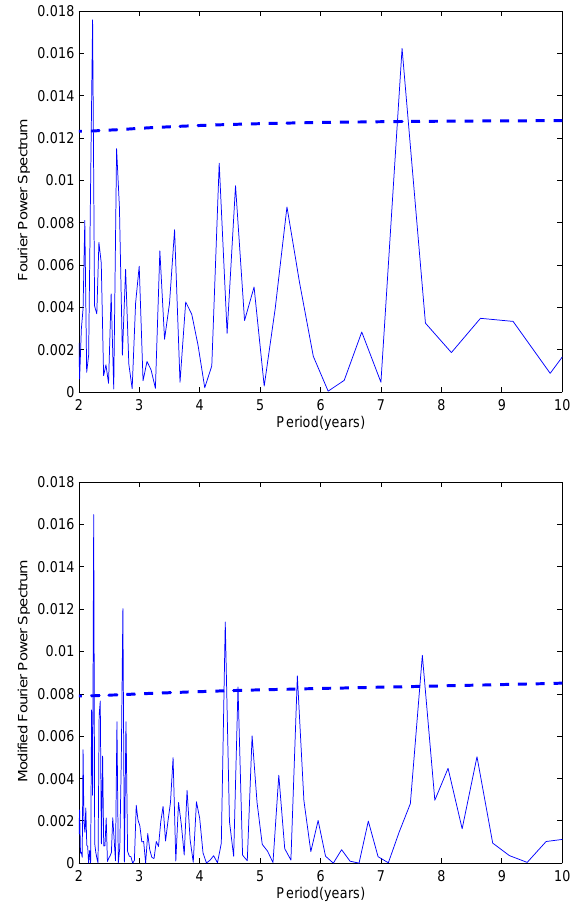
Figure 3: (Left) Fourier power spectrum is computed by discrete Fourier transform. (Right) Modified Fourier power spectrum is computed by our method. The dashed line is 99% confidence red noise spectrum . Fig. 3. (Left) Fourier power spectrum is computed by discrete Fourier transform. (Right) Modified Fourier power spectrum is Figure 4: (Top) Fourier power spectrum of AO indices is computed by discrete Fourier transform. (Bottom) computed by our method. The dashed line is 99% confidence red Fig. 4. (Top) Fourier power spectrum of AO indices is computed Modified Fourier power spectrum of AO indices is computed by our method. The dashed line is 95% confidence noise spectrum . by discrete Fourier transform. (Bottom) Modified Fourier power red noise spectrum . spectrum of AO indices is computed by our method. The dashed line is 95% confidence red noise spectrum